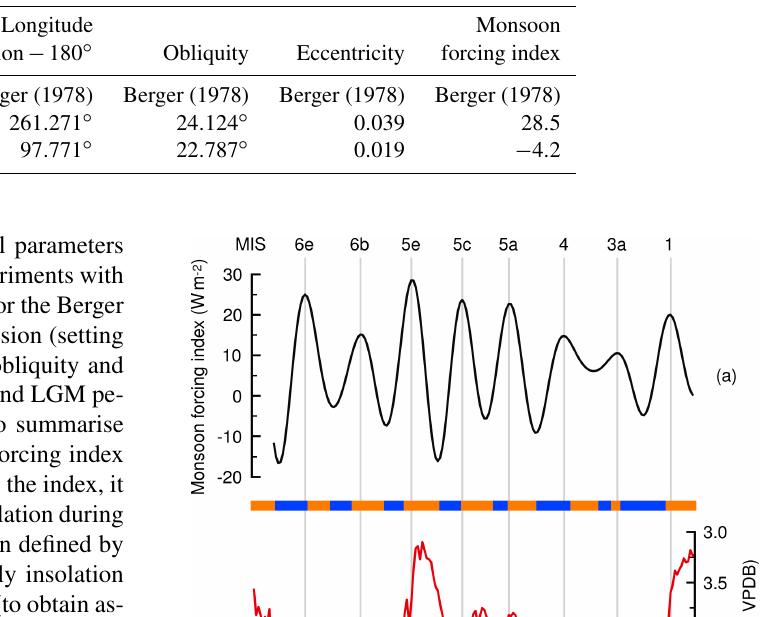
Table A1. Orbital parameters in CLIMBER-2 simulations and their respective monsoon forcing index value.